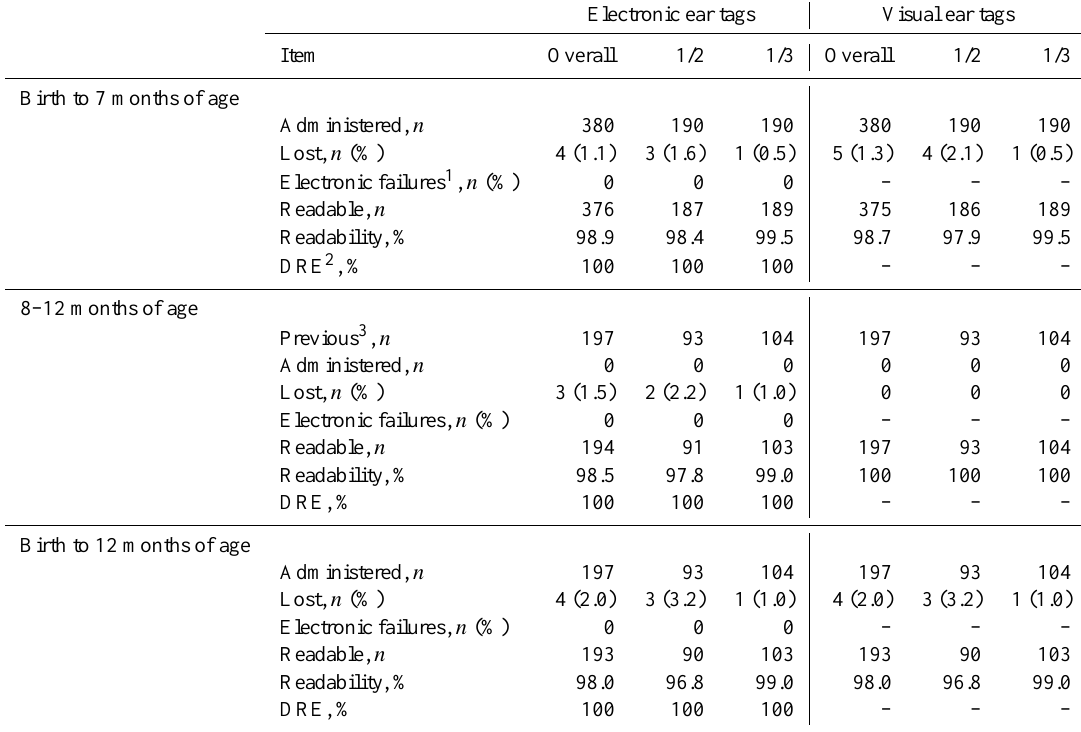
Electronic ear tags Visual ear